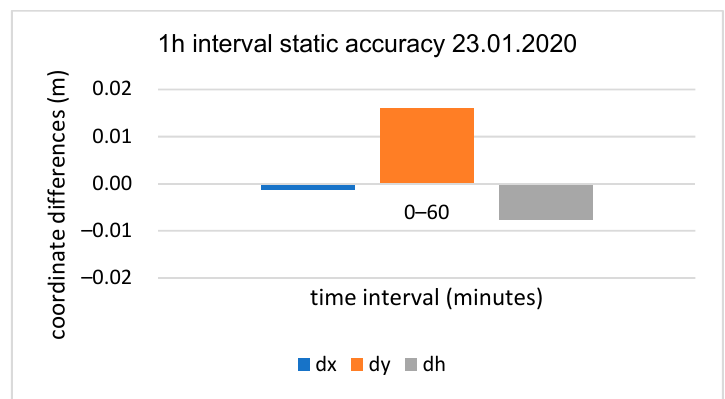
Figure 20. 30 min sub-session positioning results for the third test, baseline OPNT–P30Pro (4 km).